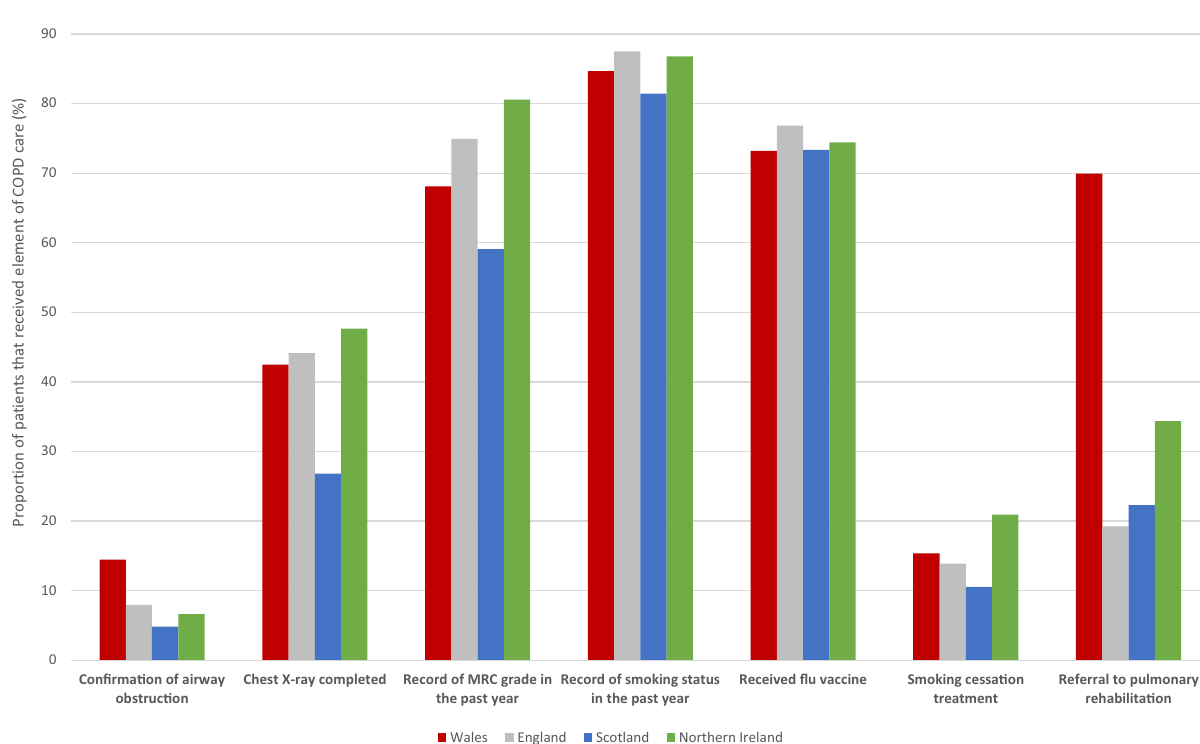
Fig. 1 Proportion of patients receiving key items of COPD care in Welsh, English, Scottish, and Northern Irish practices in CPRD GOLD. COPD chronic obstructive pulmonary disease, MRC Medical Research